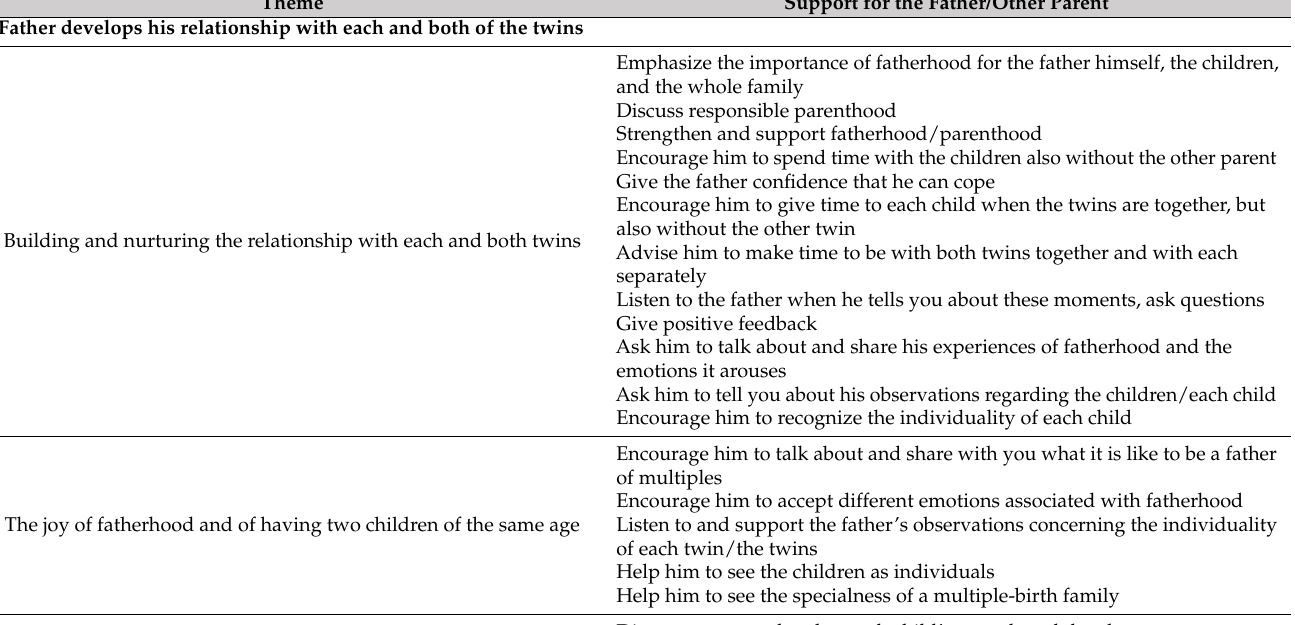
Table 1. Tips for midwives and nurses to support the fathers of twins in their parenthood.